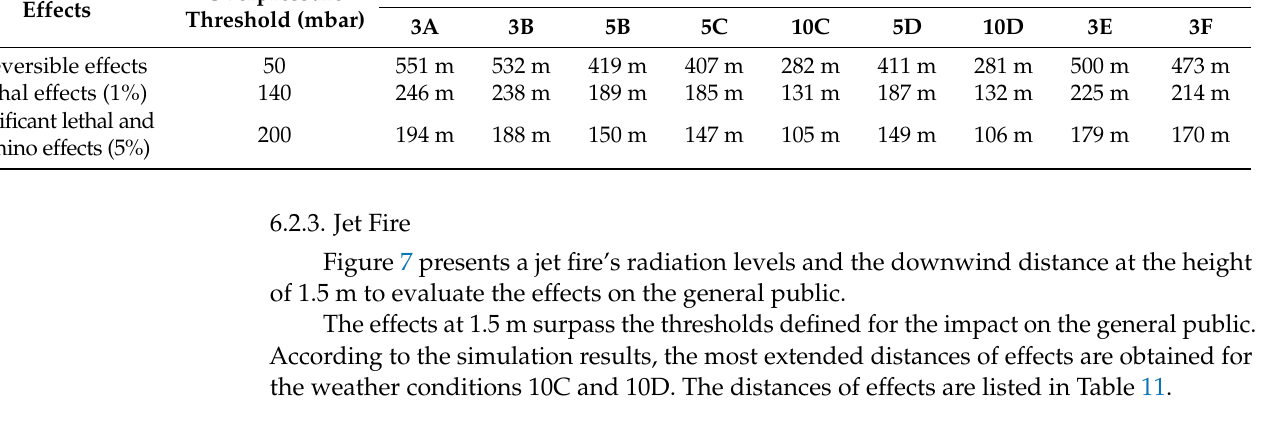
Table 11. Distances of thermal effects at 1.5 m generated by a jet fire in the EZ53 salt cavern